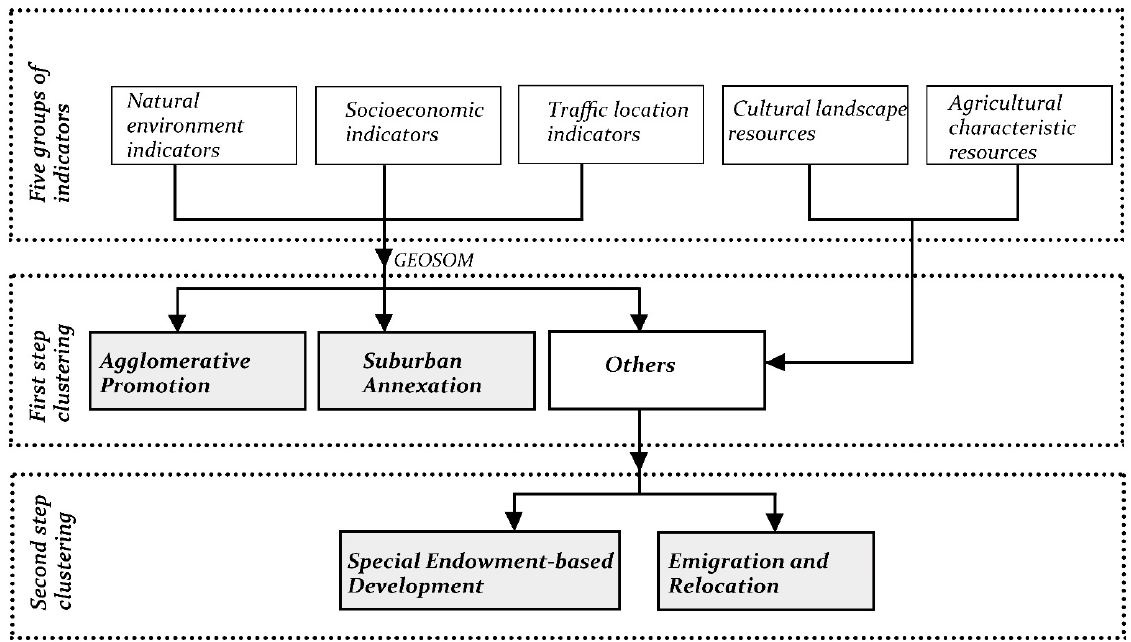
Figure 1. Analytical Framework.